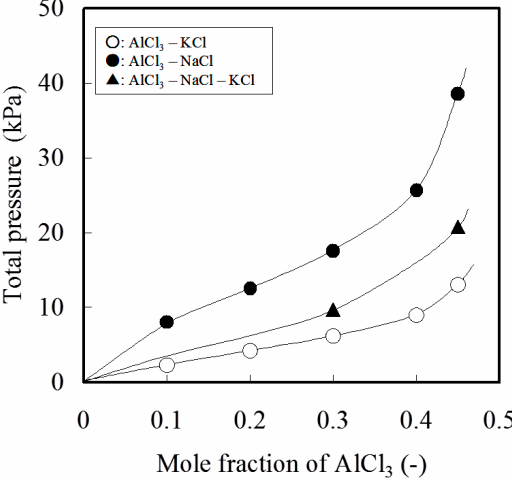
Figure 4. Total pressure of Al chloride equilibrated with AlCl AlCl –NaCl–KCl system at 1073 K. 3